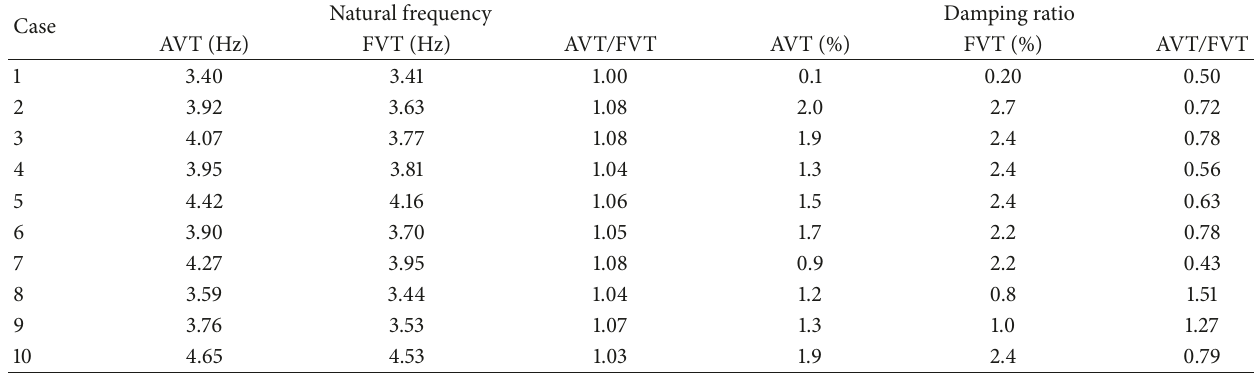
Table 5: Comparison of dynamic parameters estimated from ambient and free vibration tests. Natural frequency Damping Case